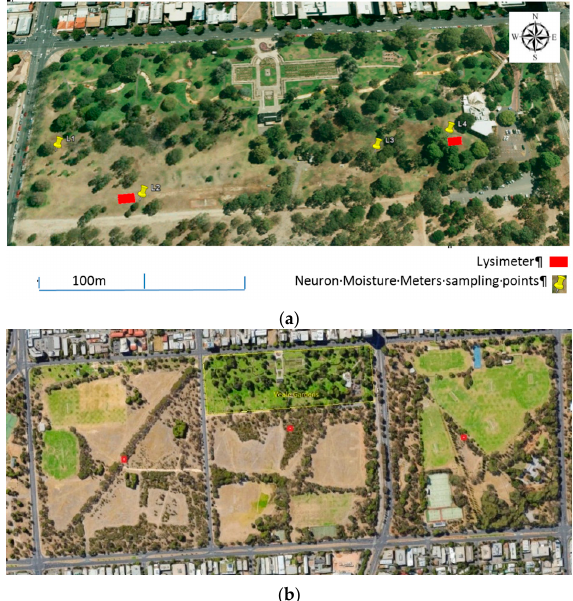
Figure 1. ( a ): instrument array for determining the soil/water balance in Veale Gardens (34,569.9140 S, 1,383,549.4899 E); ( b ): Lundie Garden, Veale Gardens, and Kurrangga Park, with red squares showing an approximate center of 250 m ˆ 259 m. Resolution Imaging Spectroradiometer (MODIS) Enhanced Vegetation Index pixels obtained to determine evapotranspiration.2.2. Experimental